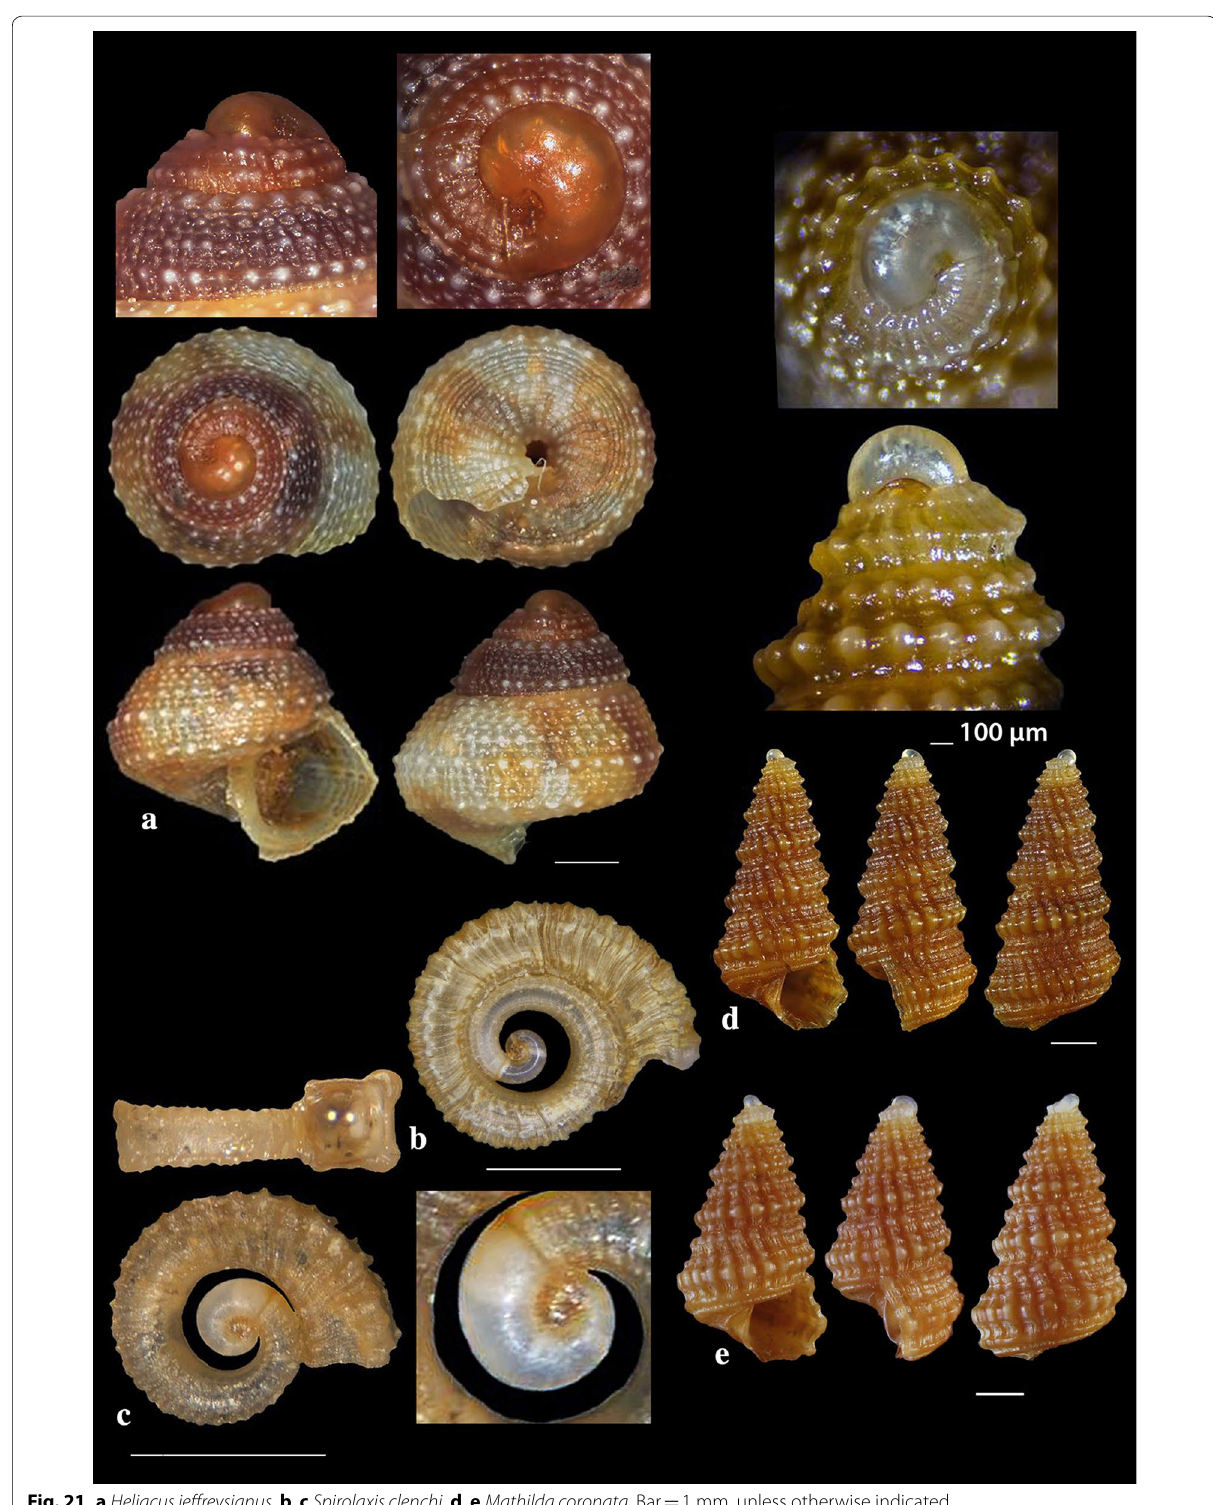
Fig. 21 a Heliacus jeffreysianus , b , c Spirolaxis clenchi , d , e Mathilda coronata . Bar